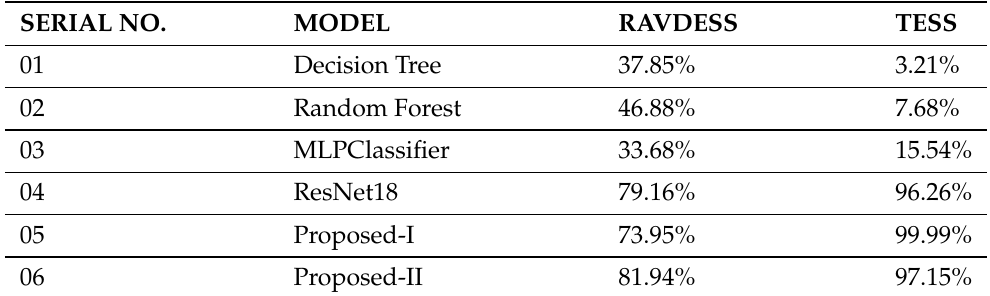
Table 3. Comparative analysis of RAVDESS and TESS. SERIAL